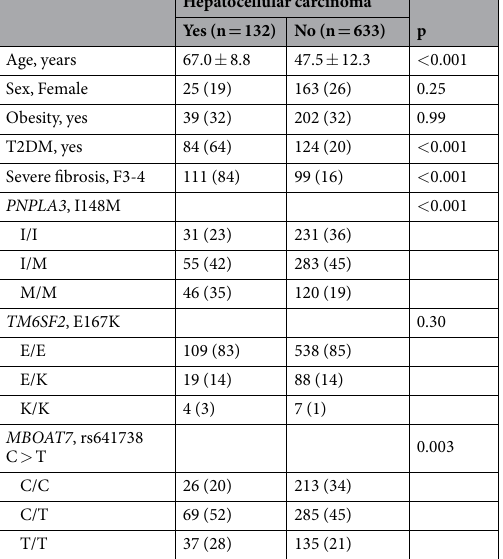
Table S1. Patients who developed HCC in the absence of severe fibrosis (n = 21, 17%) were more frequently males (p = 0.040), and carriers of the MBOAT7 rs641738 risk T allele (p = 0.006). MBOAT7 variation is associated with NAFLD-HCC in Italian patients.